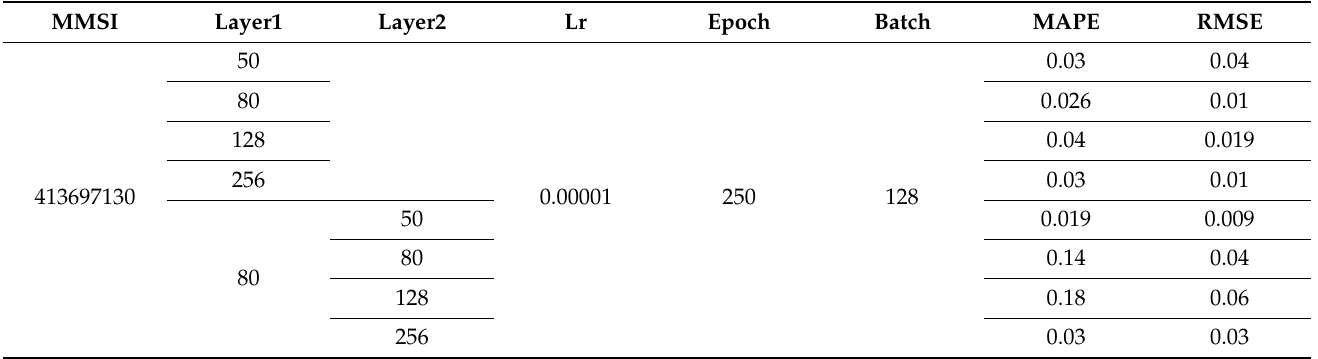
Table 3. Vessel trajectory prediction performance on different parameter settings for